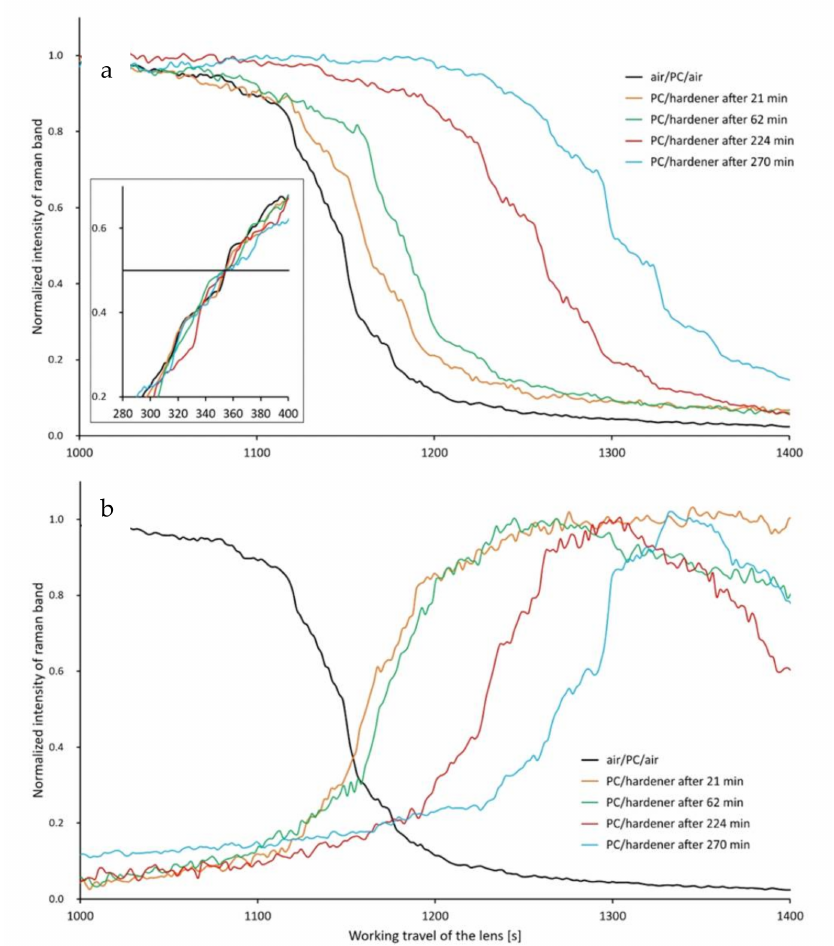
Figure A5. ( a ) Time-dependent analysis of the interface between PC and hardener, here the nor- malized Raman signal of PC is evaluated using the band at 893 ± 5 cm − 1 ; the inset shows the corrected position of the air/PC interface. ( b ) Time dependent analysis of the interface between PC and hardener, here the normalized Raman signal of the hardener is evaluated using the band at 1848 ± 5 cm − 1